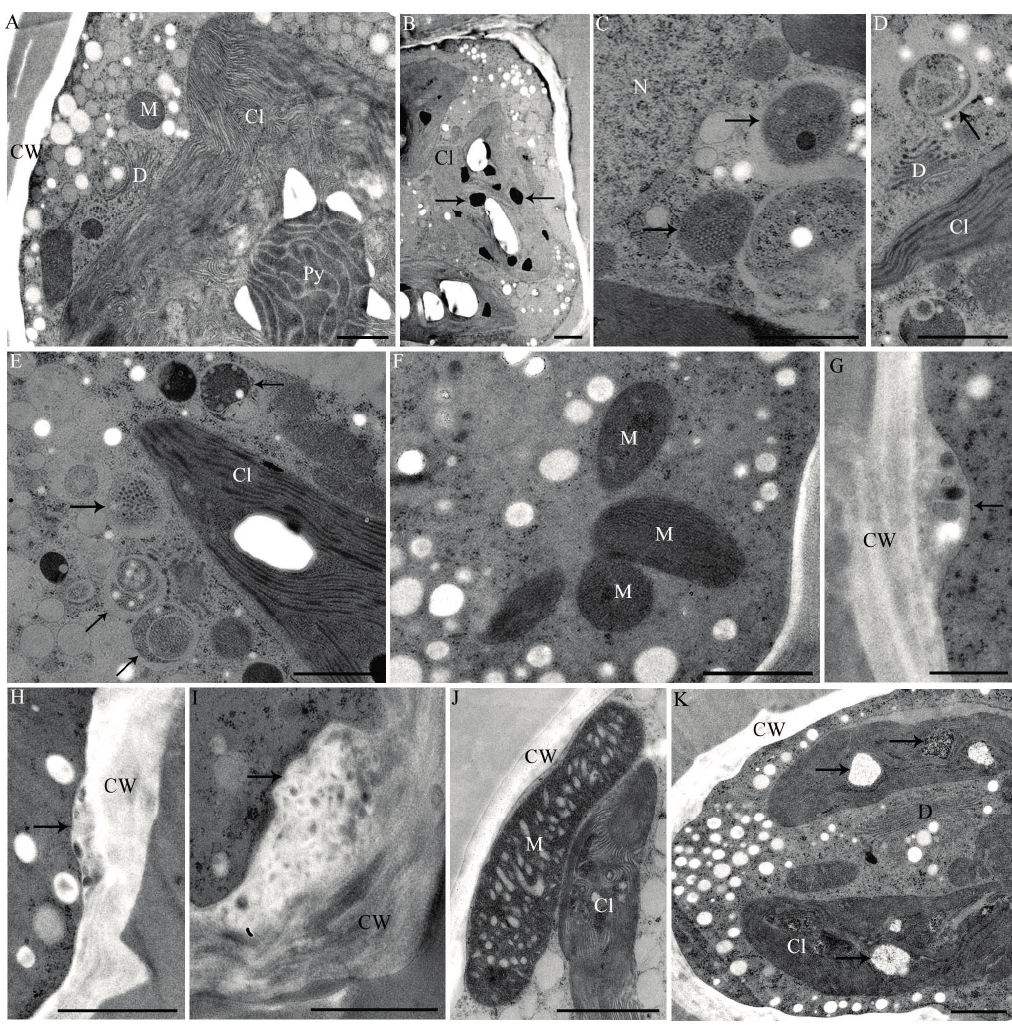
Figure 6. TEM micrographs of Desmidium. ( A ) Untreated control; ( B ) Treated with 10 µM Al 2 (SO 4 ) 3 for 21 days; ( C – E ) 0.6 µM CdSO 4 for 21 days; ( F – G ) 10 µM CrVI for 35 days; ( H , K ) 0.3 µM CuSO 4 for 21 days; and ( I , J ) 10 µM ZnSO 4 for 21 days; ( B ) Chloroplast with abnormal dark inclusions (arrows); ( C ) Altered mitochondria (arrows) and ( D , E ) autophagosomal-like structures (arrows); ( F ) Cr-treated cell without visibly affected mitochondria; ( G – I ) Abnormal depositions on the cytoplasmic site of the cell wall (arrows) induced by Cr ( G ), Cu ( H ) and Zn ( I ); ( J ) Enlarged mitochondrion after Zn treatment, close to the chloroplast. Cristae are distinctly enlarged and bloated; ( K ) Vacuole-like structures in the chloroplast (arrows). Cl: Chloroplast; CW: Cell wall; D: Dictyosome; M: Mitochondrion; N: Nucleus; Py: Pyrenoid. Bar = 1 µm, except ( D , E ) = 0.5